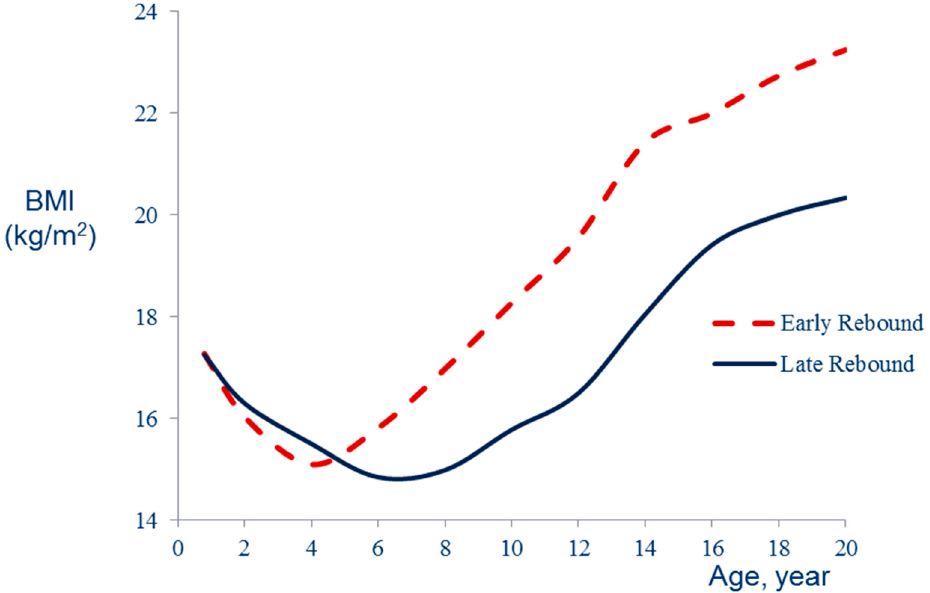
Figure 1. Body mass index (BMI) (kg/m 2 ) development according to age (year) at adiposity rebound (after [3]).